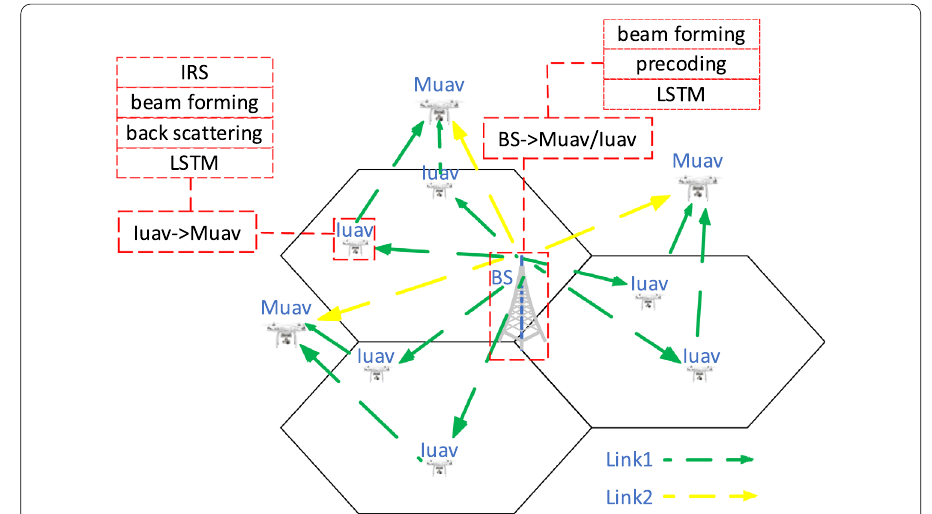
Fig. 5 Key technologies included in the two